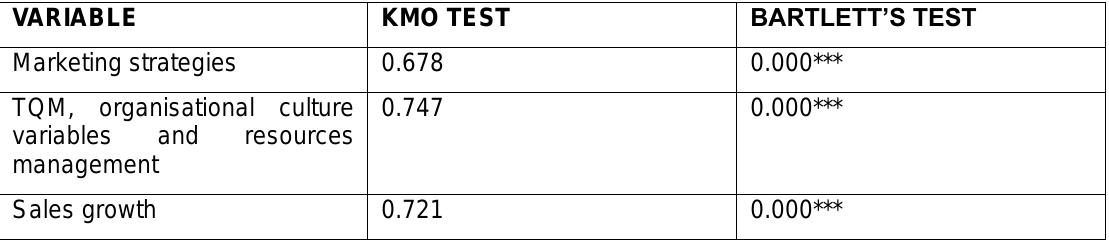
Table 3: kmo measure of sampling adequacy and bartlett’s test of sphericity